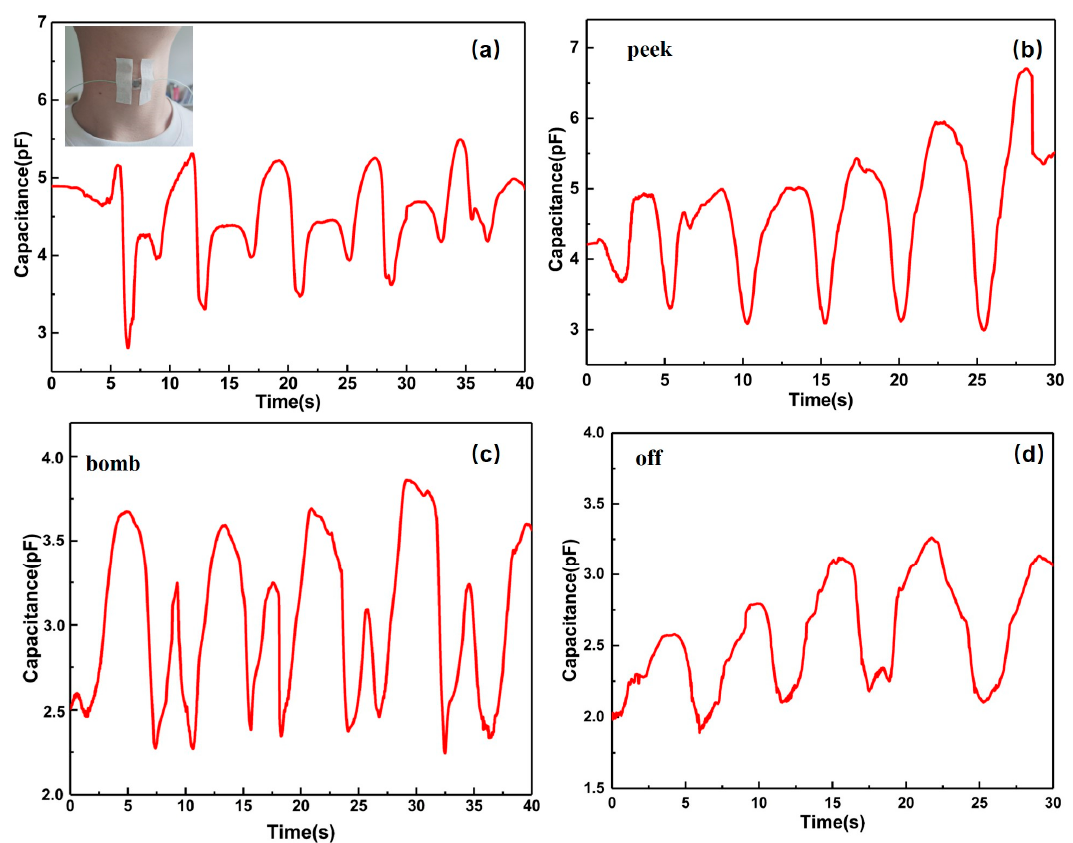
Figure 9. Human laryngeal movement information test ( a ) laryngeal movement test; ( b ) word “peek” test; ( c ) word “bomb” test; ( d ) word “off’ test. test; ( c ) word “bomb” test; ( d ) word “o ff ’